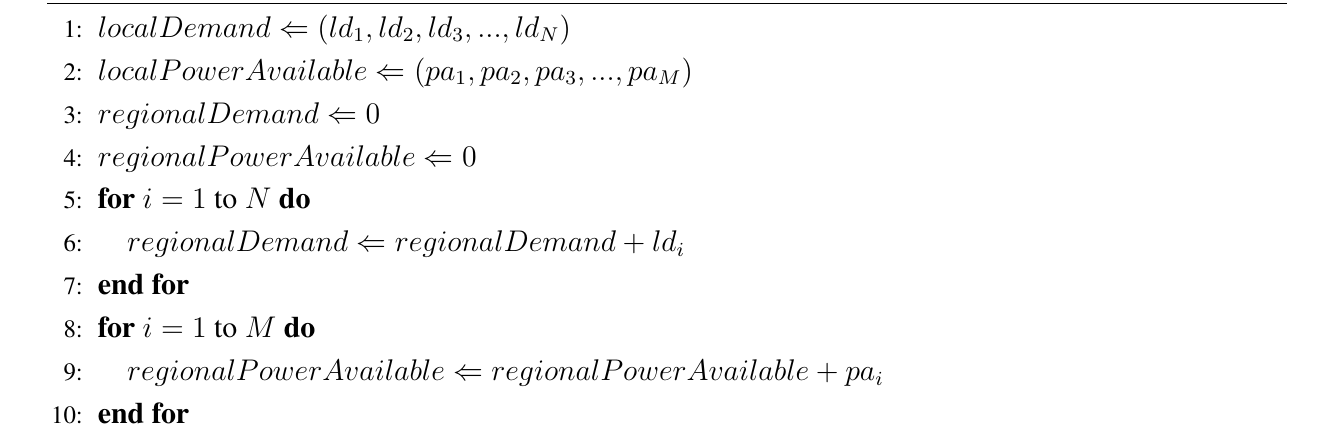
Algorithm 6 The information aggregation process in the regional control